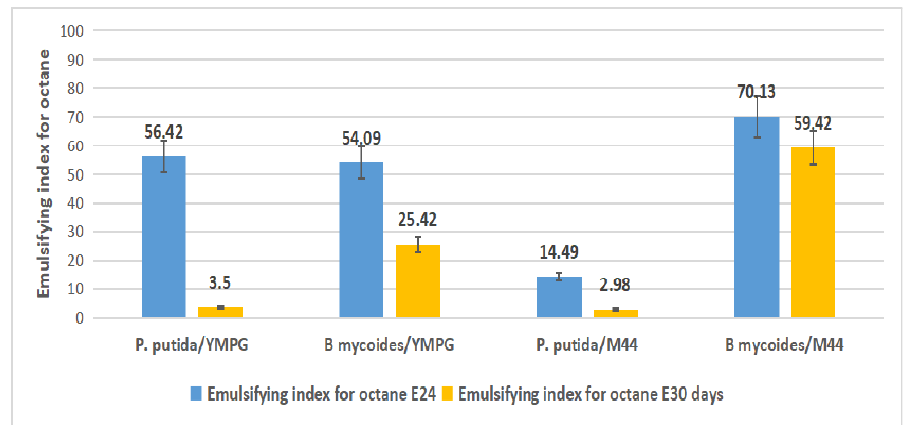
Figure 14. Emulsifying index for octane (LB and KB).